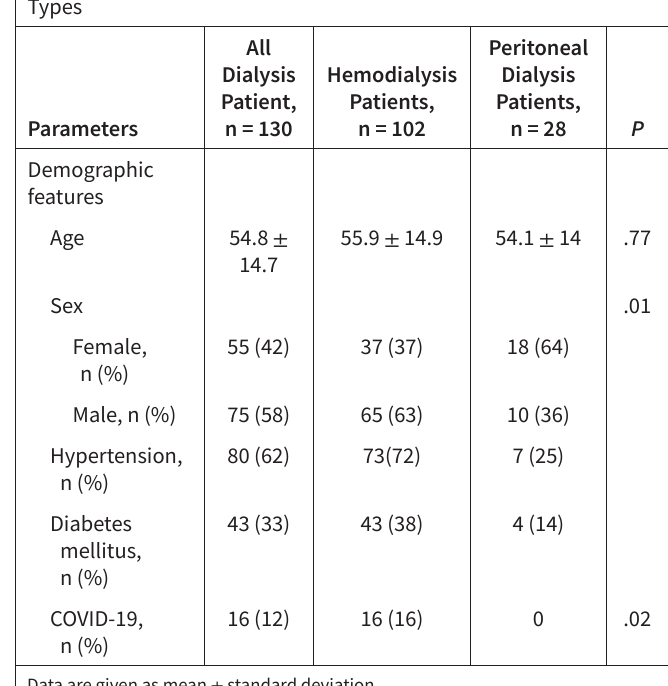
Table 1. Characteristics of Patients Classified According to